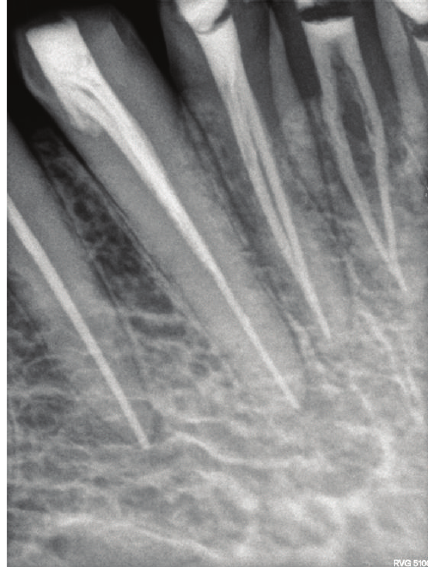
Figure 6: Radiograph showing obturation in two separate canals in 31 and 32.